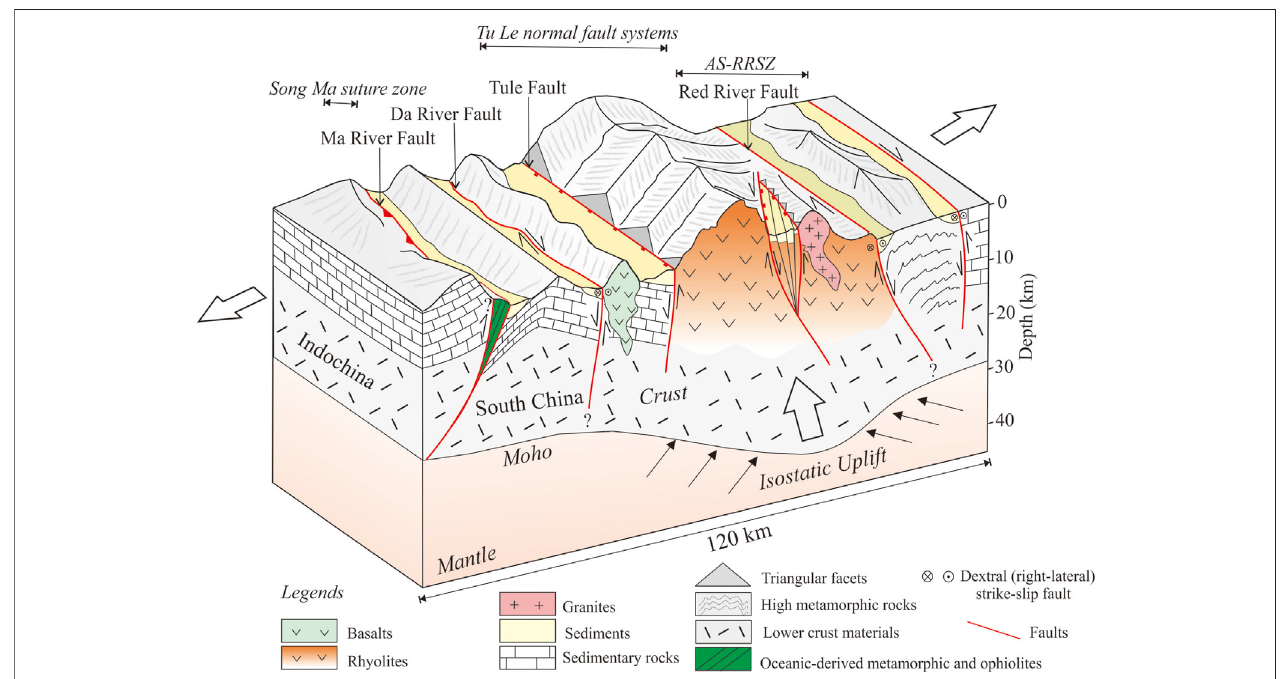
FIGURE 14 | Schematic 3-D diagram showing fault systems within and surrounding the study area. The uplift of the Fansipan and Tule mountain range was probably controlled by extensional tectonics that created the space in upper crust to make lower materials moving upward by isostatic rebound.